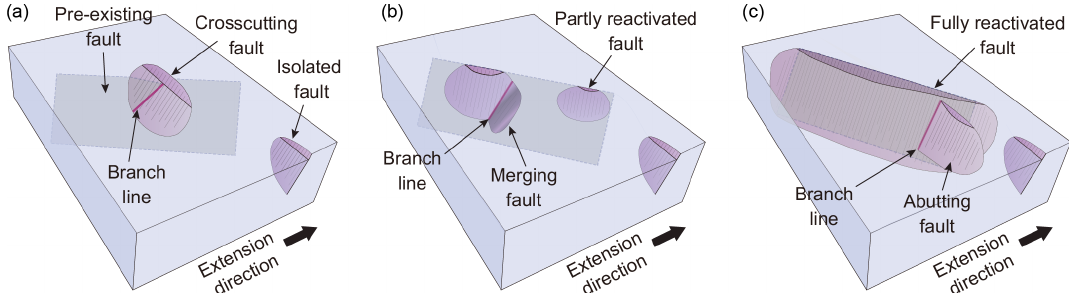
Figure 11. Summary figure showing the variety in the reactivation mode of pre-existing thrust faults and fault interaction styles developing during later rifting: (a) no reactivation, (b) partial reactivation, and (d) full reactivation. The grey rectangle is a pre-existing thrust fault existing beneath the surface, and the purple oval is a new fault. The black fault traces indicate the surface expressions of faults. The purple line is the branch line at the intersection between fault